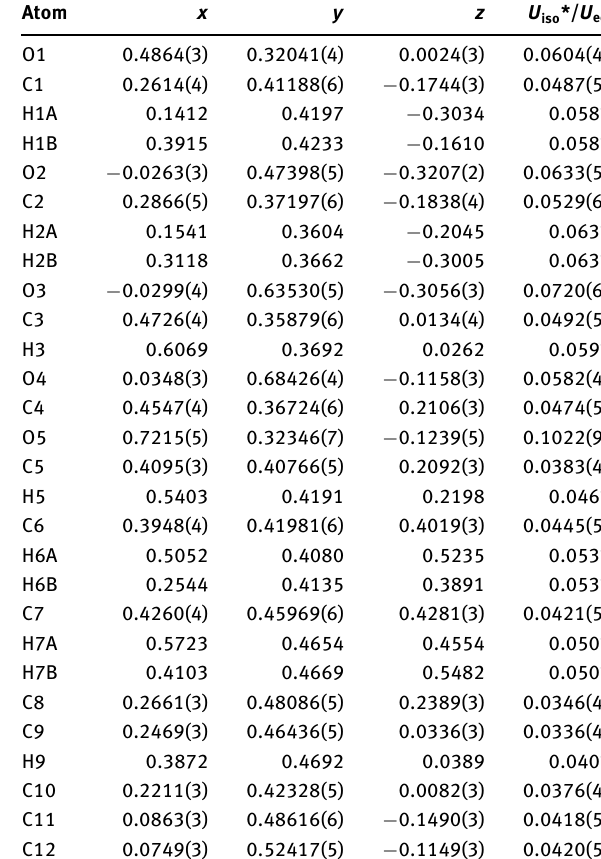
Table 2: Fractional atomic coordinates and isotropic or